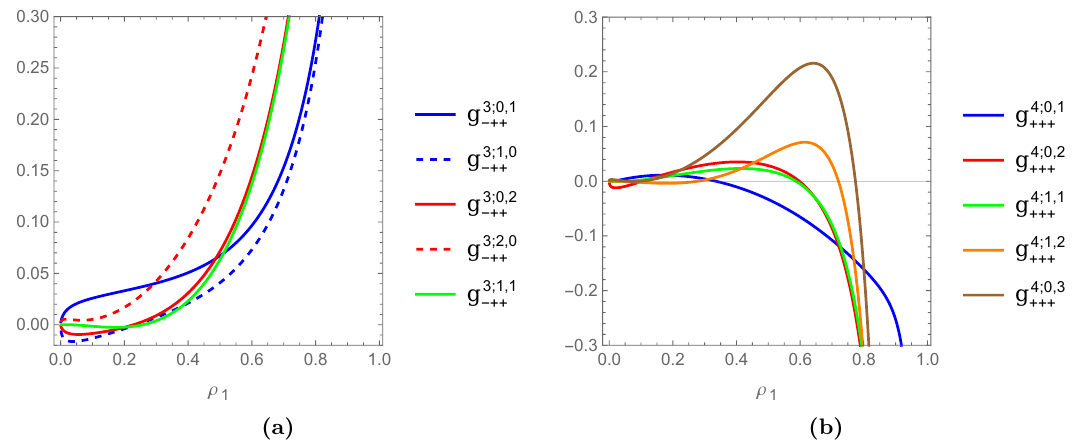
Figure 3 . Plots on the TPP symmetric line of different terms in the LL expansion. (a) Different components of the 3-loop NMHV ( − ++) amplitude related to (++ − ) by target-projectile exchange. (b) Different components of the 4-loop MHV amplitude. The omitted components are related by target-projectile symmetry. To make the components of similar numerical size, we divided them by ( − 16) L / ( − 2 π ) l , where l is the total order in the LL expansion, l = n 1 + n 2